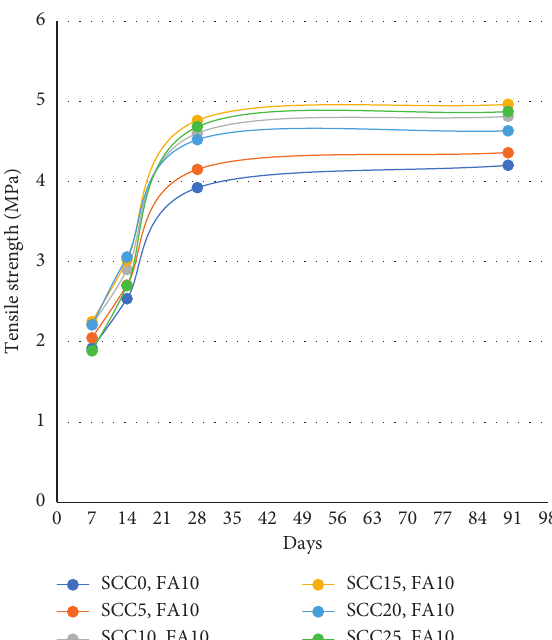
Figure 7: Tensile strength test results for concrete mixes with 10% replacement of fly ash.